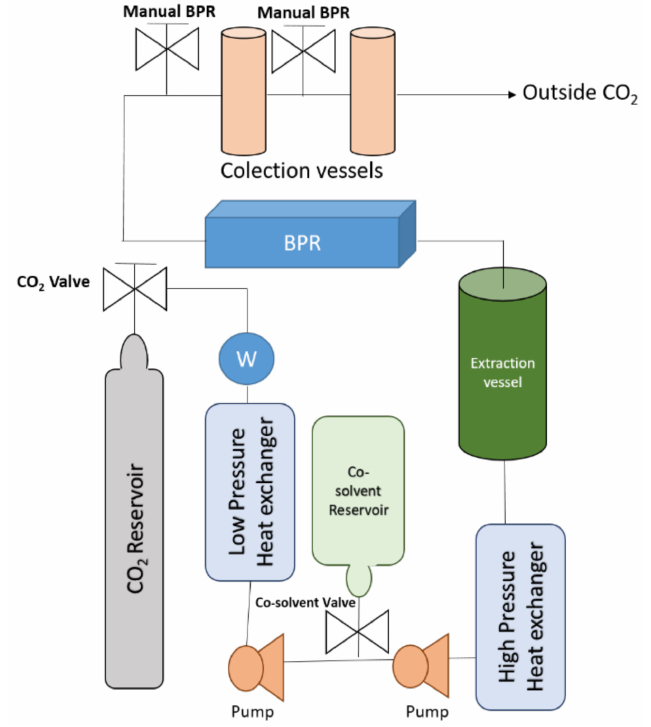
Figure 2. Diagram of supercritical fluid extractor. W: chiller; BPR: back pressure